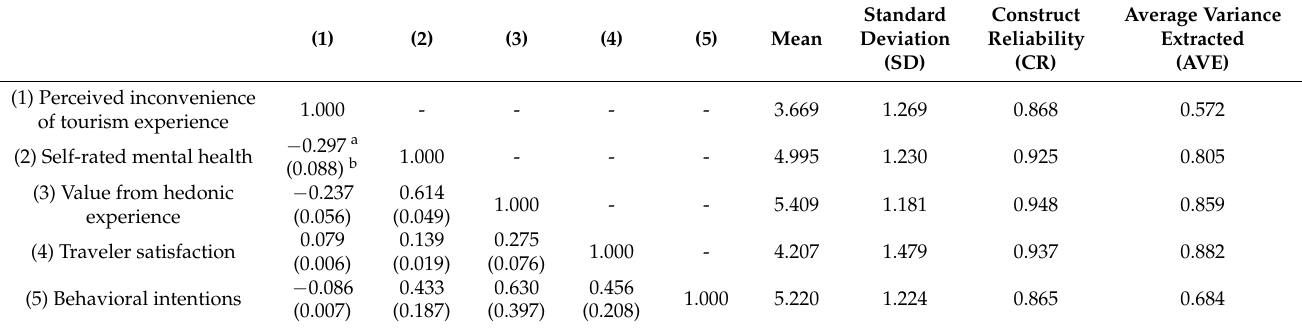
Table 1. The measurement model